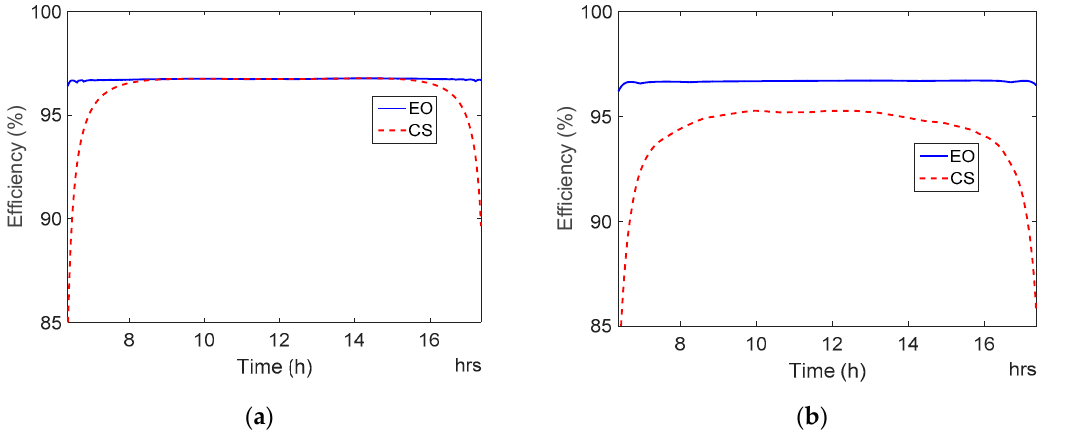
Figure 17. Daily efficiency curves of Perfect Galaxy International Ltd EQX0250UV480TN with average Figure 17. Daily e ffi ciency curves of Perfect Galaxy International Ltd. EQX0250UV480TN with current-sharing control method ( CS ) and efficiency-oriented method ( EO ). ( a ) Sunny day. ( b ) Cloudy average current-sharing control method ( CS ) and e ffi ciency-oriented method ( EO ). ( a ) Sunny day. ( b ) day. Cloudy day.